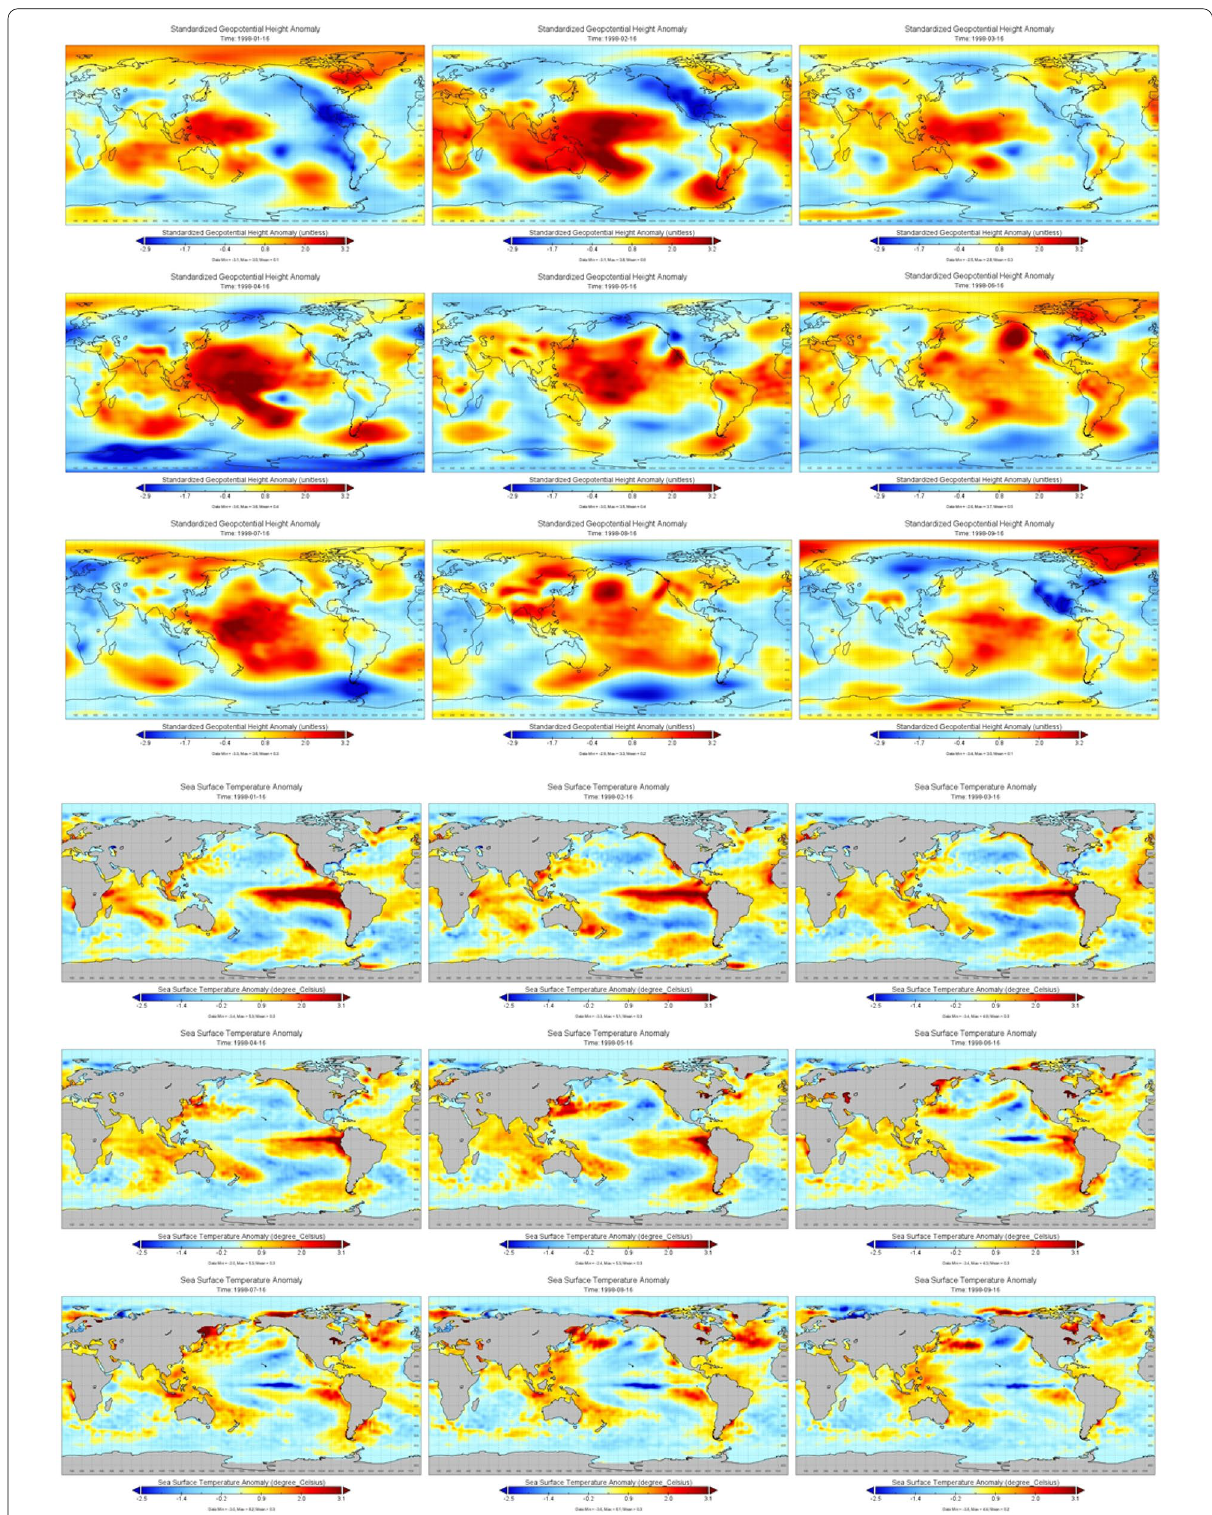
Fig. 14 Global-scale GPH and SST anomaly (January to September